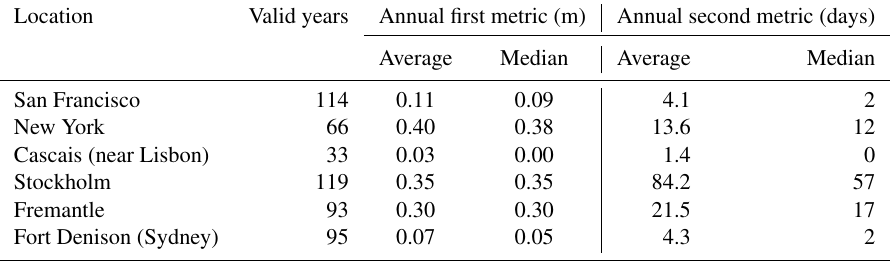
Table 1. First column: location. Second column: no. of valid years in analysis. Third and fourth columns: average and median of annual first metric , which is height of highest observed sea level above observed maximum on day of highest predicted tide for the year, for daylight days ( o d (I od (j,k),j,k) − o d (I pd (j,k),j,k) ), over all valid years, j . Fifth and sixth columns: average and median of annual second metric , which is no. of days when observed sea level, o d (i,j,k) , higher than observed maximum on day of highest predicted tide for the year,